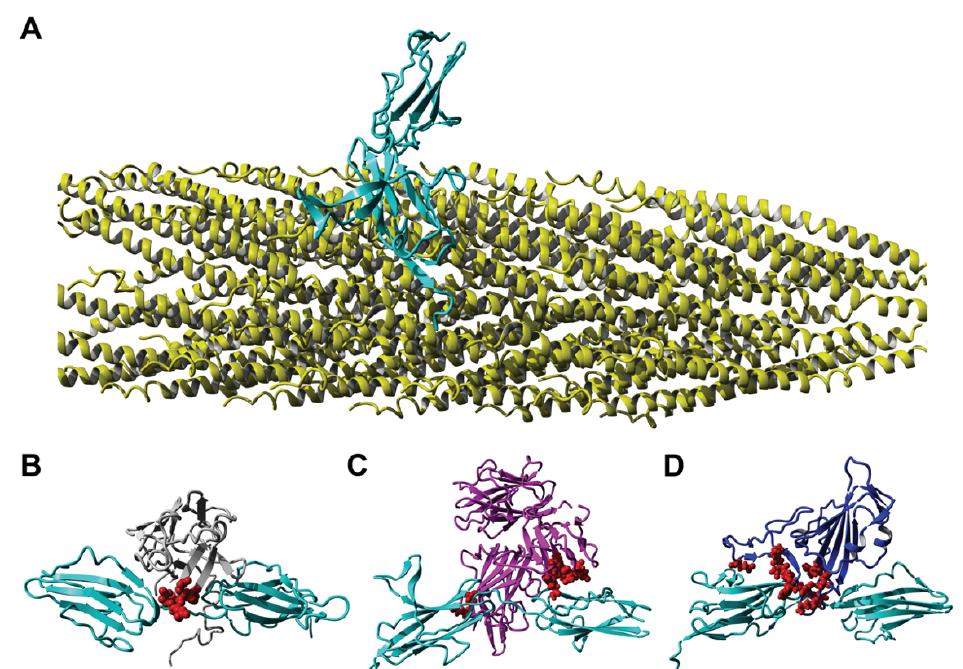
Figure 8. Interaction of fibroblast growth factor receptor 3 (FGFR3) with different ligands: ( A ) Interaction of a landscape phage displaying the peptide EDYSELVSQ (yellow) on the full-length p8 protein with FGFR3 (cyan), as determined using homology modeling. Here, a segment containing less than 1% of the landscape phage is presented, where the EDYSELVSQ peptide is presented as an N-terminal fusion to all copies of the mature p8 major coat protein. Interaction of FGFR3 (cyan) with ( B ) FGF1 (gray), ( C ) NRP1 (magenta), or ( D ) SARS-CoV-2 spike RBD (blue), with amino acid clusters containing alignments to the EDYSELVSQ mimotope highlighted in red. Table 2. Amino acid clusters identified on the surface of ligands and their corresponding phage mimotopes. Bold letters highlight the amino acid residues shared with the phage mimotope.